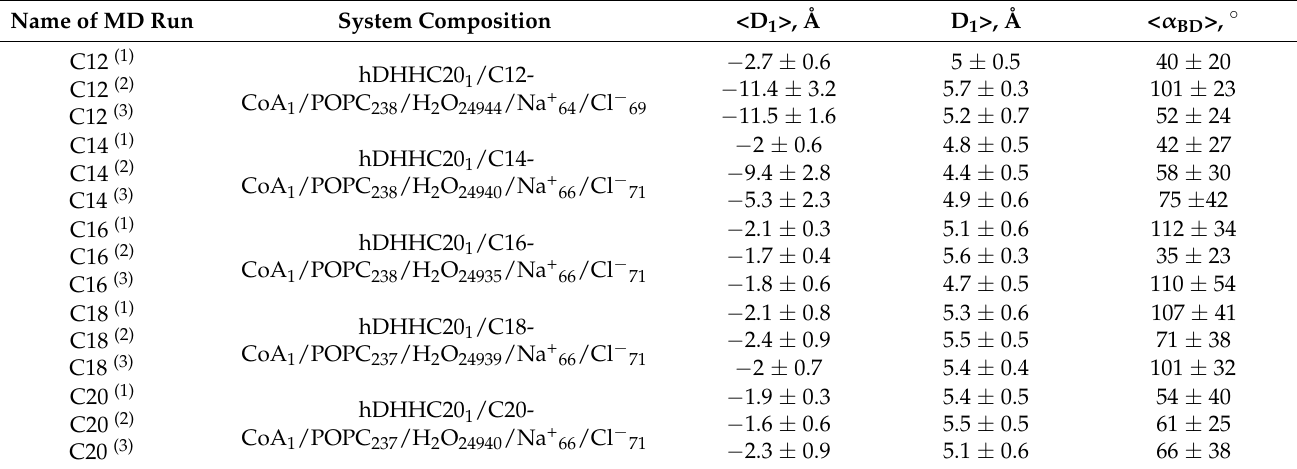
Table 1. Systems used in MD simulations